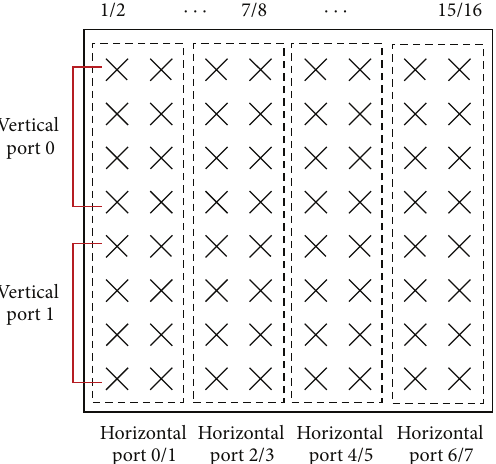
Figure 4: Antenna array with 8 × 8 X-pol elements.